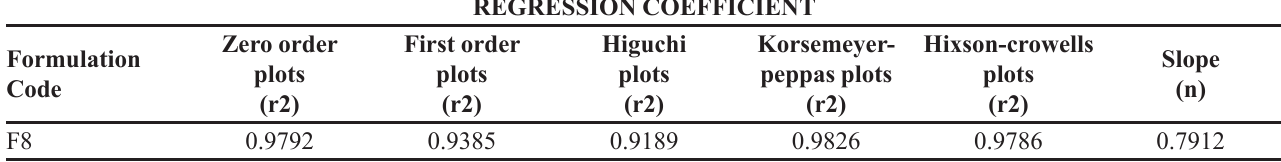
REGRESSION COEFFICIENT